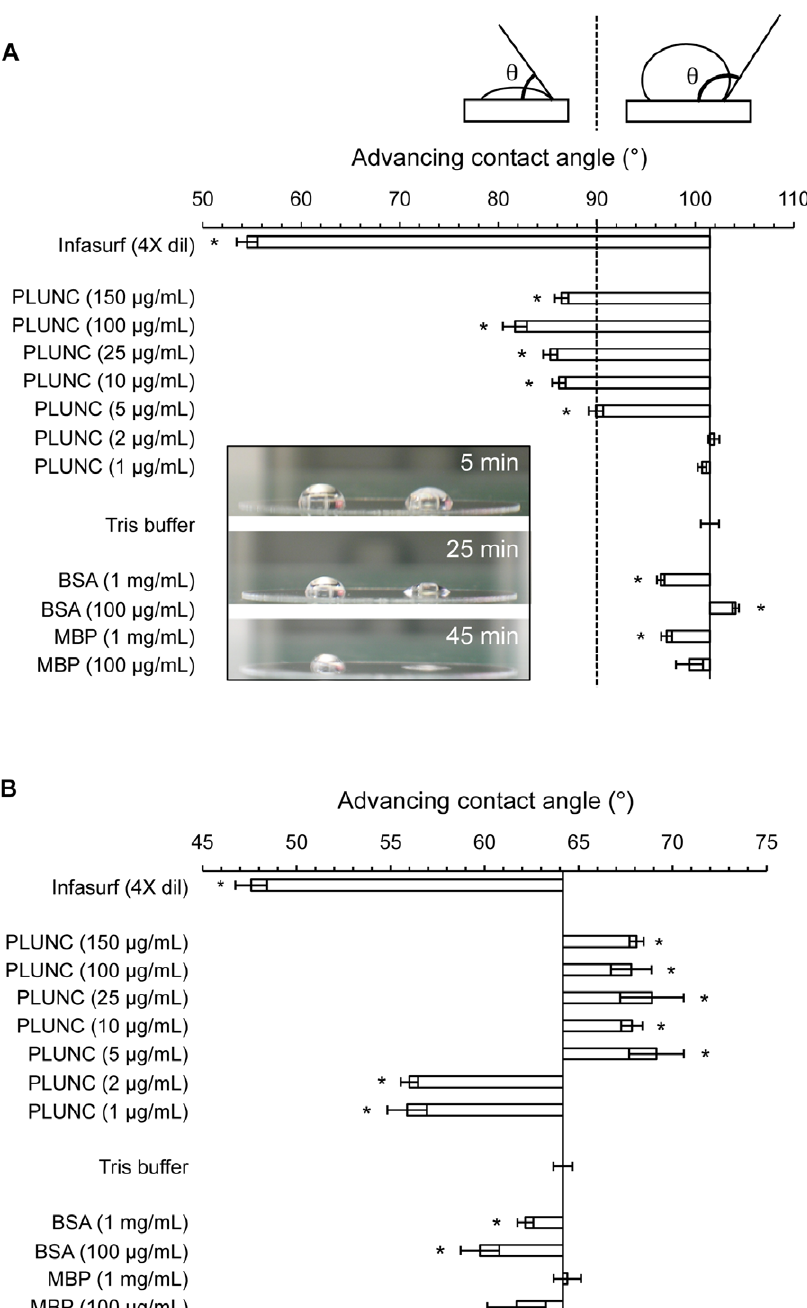
Figure 4. Contact angle measurements suggest that PLUNC possesses surface activity. (A) Advancing contact angles were measured by the sessile drop technique for various solutions dispensed onto siliconized glass, a hydrophobic surface. Bars depict the mean values for contact angles (in degrees) measured one minute after drops were dispensed onto the solid surface. Error bars represent the standard error about the mean (n=6). Contact angles ( h ) of less than 90 u (dotted line in panel A) indicate wetting of the surface by the drop, whereas contact angles greater than 90 u (to the right of the vertical line) indicate that a sample is ‘‘non-wetting’’. The solid vertical line separates the solutions that have greater wetting ability than buffer alone (bars pointing left) from the ones that have lesser wetting ability (bars pointing right). Asterisks denote measurements that are significantly different from buffer, as determined by Student’s two-tailed t-test ( P -value , 0.01). On a hydrophobic surface, PLUNC solutions transitioned from ‘‘non-wetting’’ to ‘‘wetting’’ at concentrations greater than 10 m g/mL. Inset : spreading behavior over time was compared for Tris buffer and a PLUNC-containing solution dispensed onto a hydrophobic surface. On each coverslip, the drop on the left is buffer, while drops of PLUNC (140 m g/mL) are shown on the right. Drop spreading was photographed after 5 minutes, 25 minutes, and 45 minutes, revealing that the presence of PLUNC conferred an increased tendency for an aqueous solution to spread on a hydrophobic surface. In panel (B), drops of test solutions were formed on unmodified glass, a hydrophilic surface, and advancing contact angles were measured as described above. On a hydrophilic surface, PLUNC enhanced wetting when at lower concentrations (1–2 m g/mL), while higher PLUNC concentrations (5–150 m g/mL) appeared to reduce wetting ability. Infasurf, a commercial lung surfactant, displayed significant wetting ability on both hydrophilic and hydrophobic surfaces.